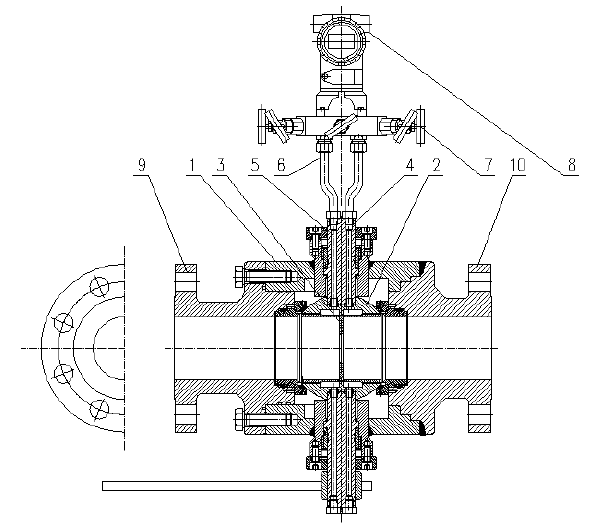
Figure 4: The cross-section of the prototype, 1 - Valve body, 2 - Ball, 3 - Measuring orifice, 4 - Spindle, 5 – Pressure impulse channel, 6 - Impulse tube, 7 - Five-way valve, 8 - Differential pressure transducer, 9 - Inlet connection flange, 10 - Outlet connection flange